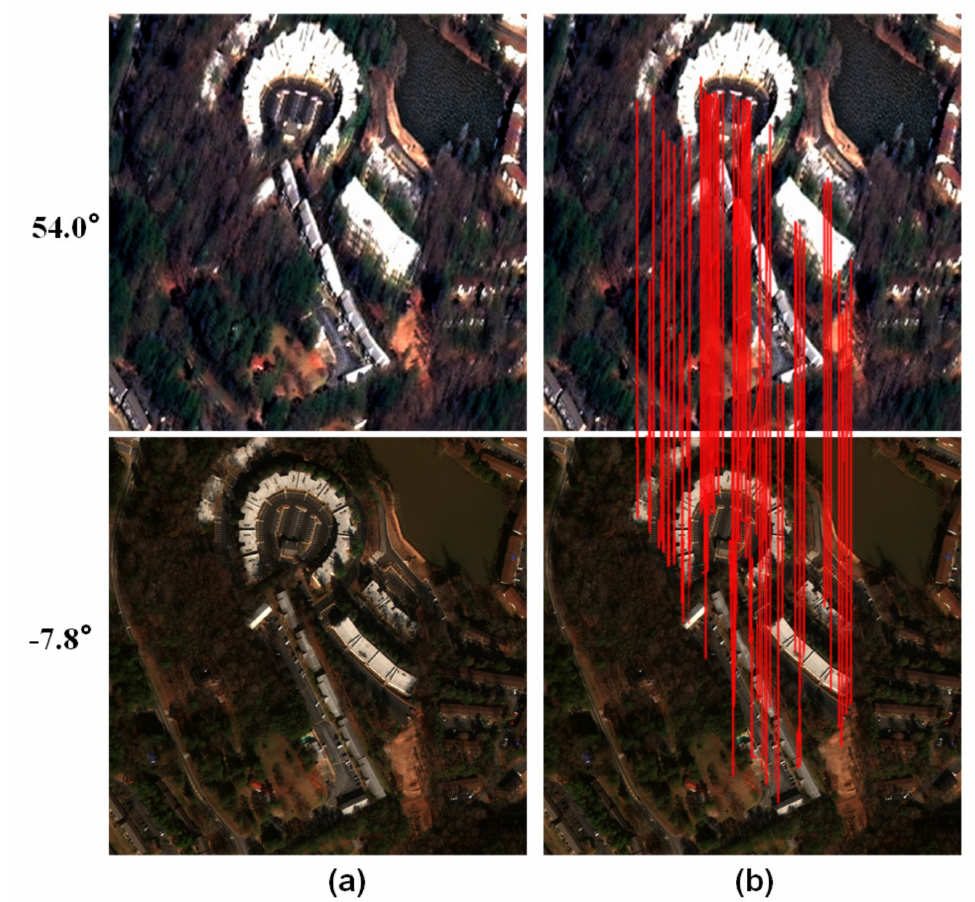
Figure 10. Matching performance comparison. ( a ) SIFT. ( b )